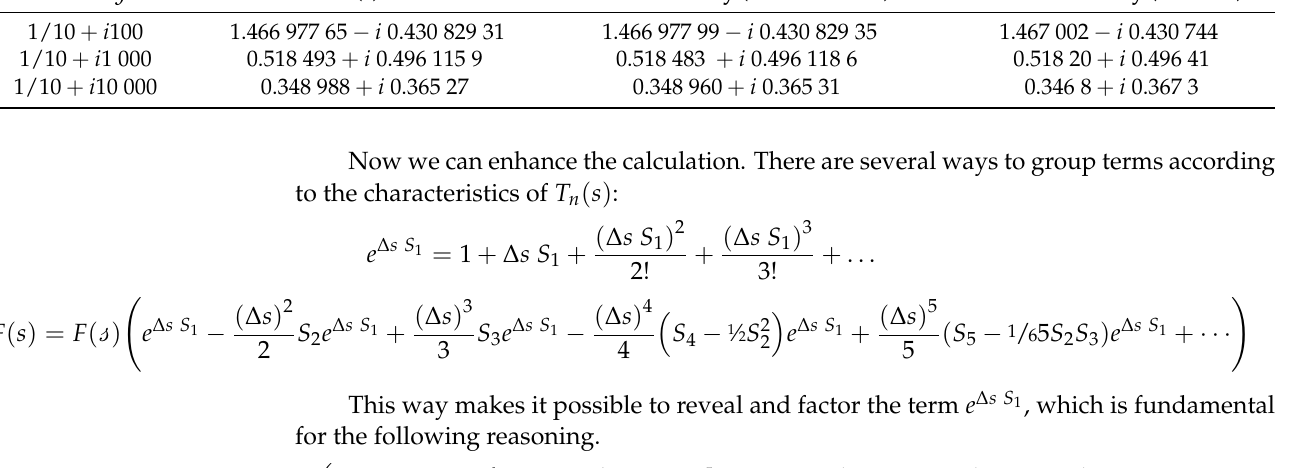
Table 4. General case not close to a zero: F estimation in the CS from the CL (same y ) via both methods with F ( n ) and T n . This table shows the good accuracy of the F estimation with eight terms using the indirect way, with various y : 100, 10 3 , 10 4 . s = x +